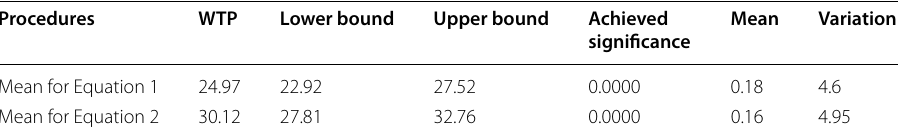
Table 5 The mean willingness to pay for Gedo Natural Forest conservational benefits . Source: Author’s estimation,